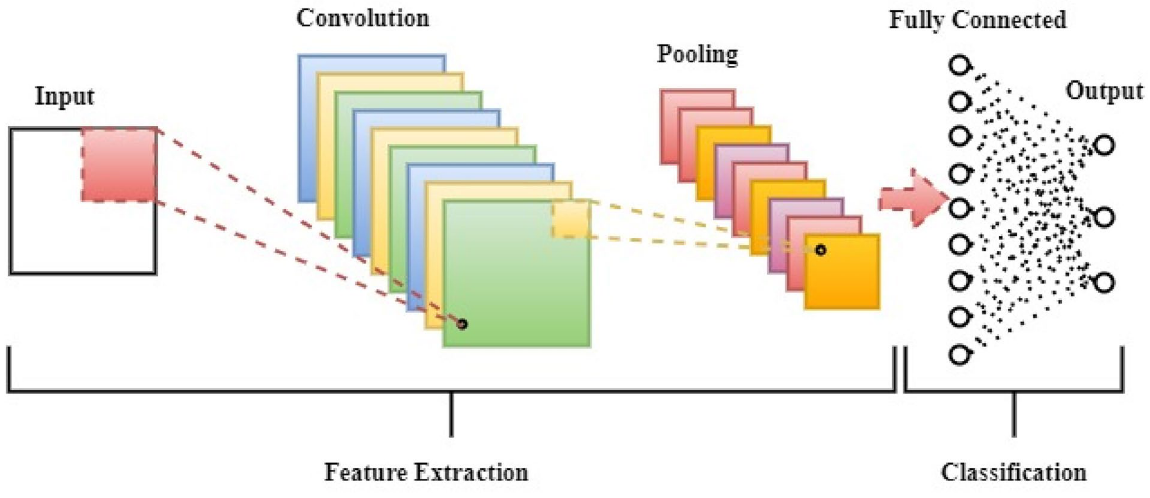
Figure 5. Convolutional neural network